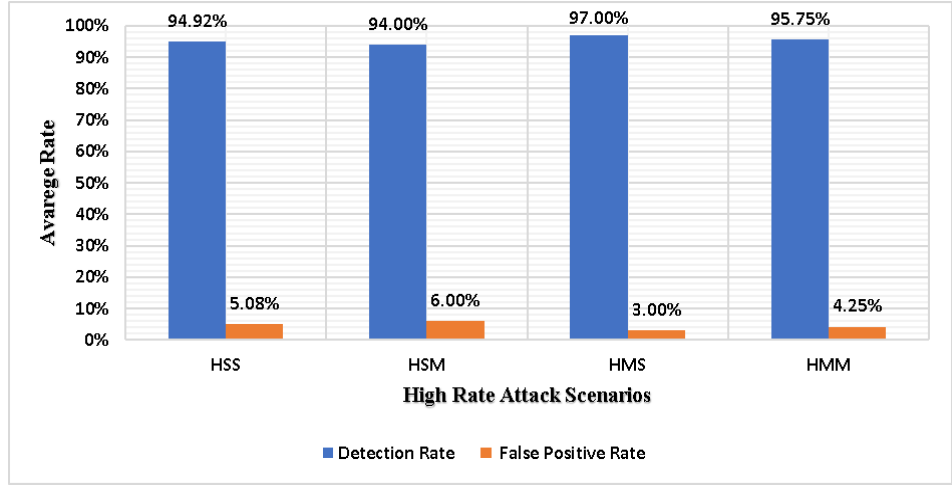
Figure 4. Average DRs and FPRs using high-rate attack scenarios in 30 min.